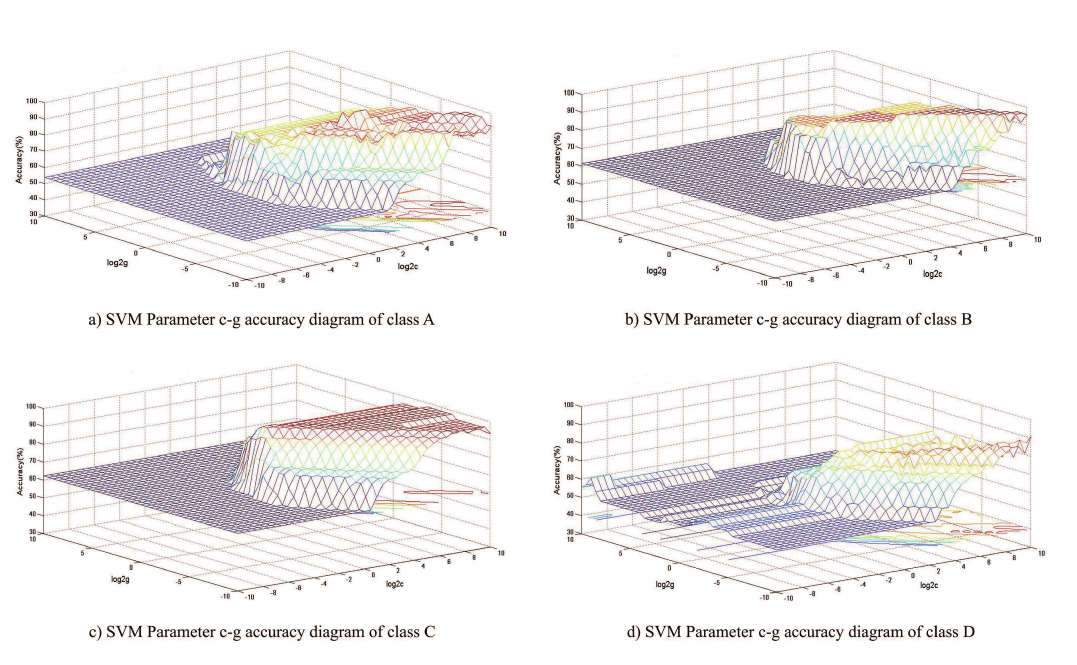
Figure 10. Optimization results of various SVM parameters c–g. ( a ) SVM parameter c-g accuracy diagram of class A. ( b ) SVM parameter c-g accuracy diagram of class B. ( c ) SVM parameter c-g accuracy diagram of class C. ( d ) SVM parameter c-g accuracy diagram of class D. Table 6. Summary of classification results of test